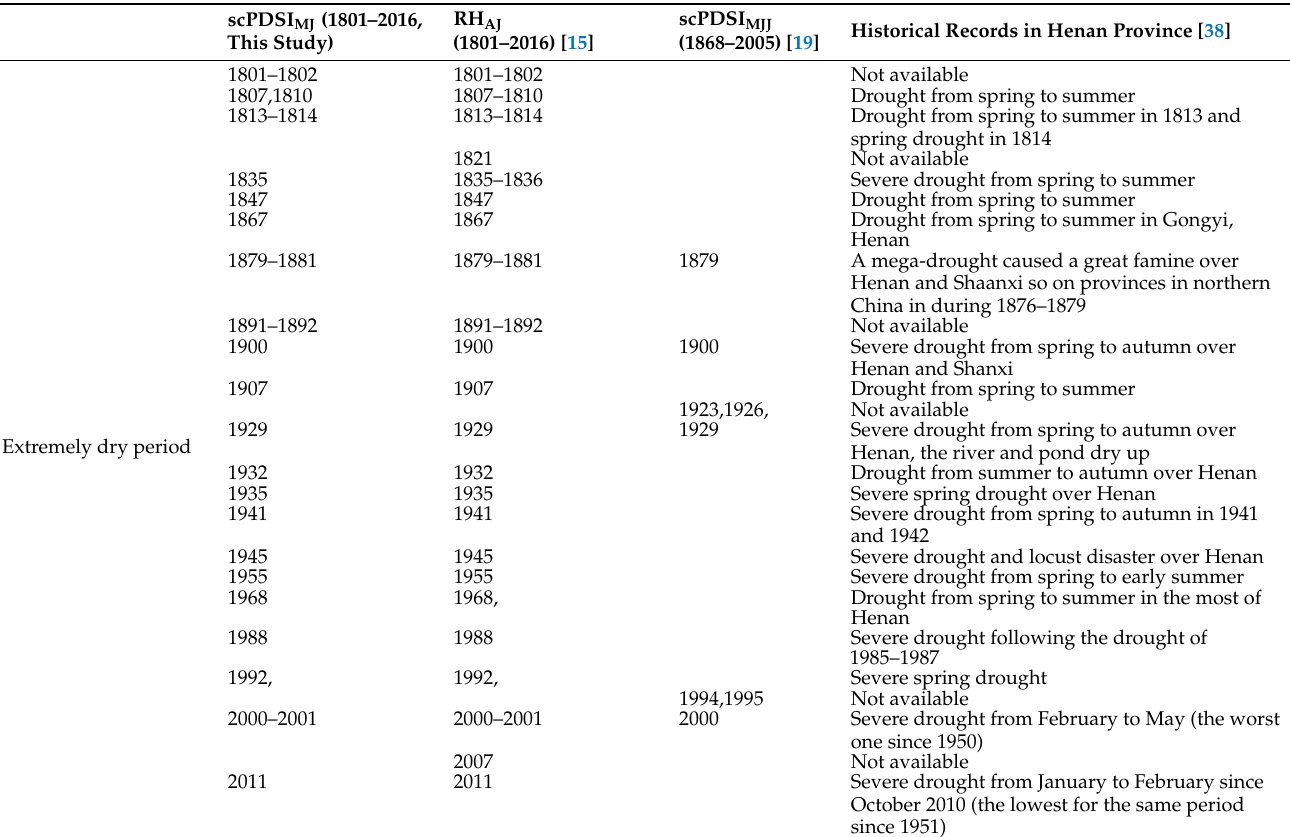
Figure 7. Reconstructed scPDSI MJ and 11 year smoothing curve (blue line) at Mt. Shiren during 1801–2016. The thick and dotted horizontal lines represent mean scPDSI MJ and its standard deviation, respectively. Table 3. Moderately to extreme drought/wet events derived from tree-ring reconstructions and the corresponding descriptions of historical